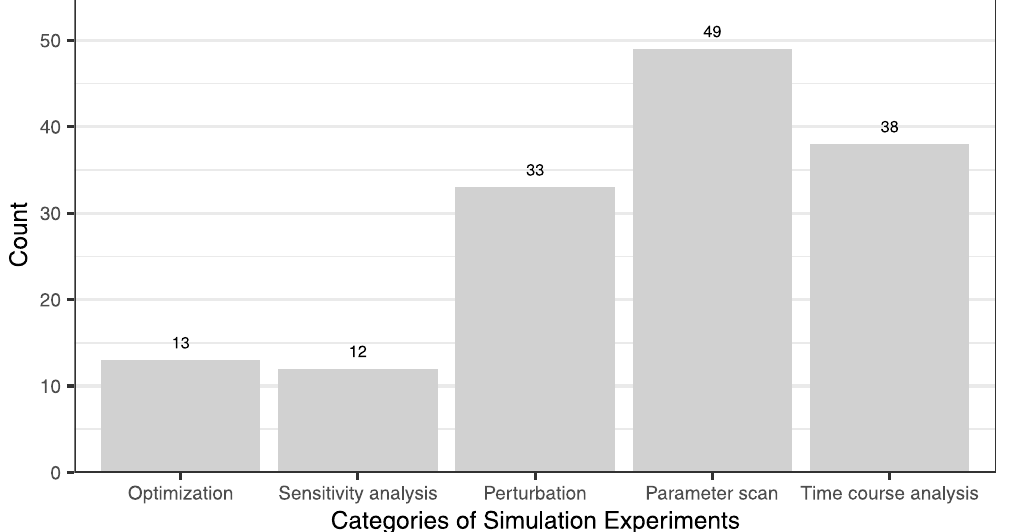
Fig 5. Categories of the simulation experiments conducted within the analyzed 19 Wnt signaling studies. All of these simulation experiments have been categorized. Most simulation experiments were parameter scans.